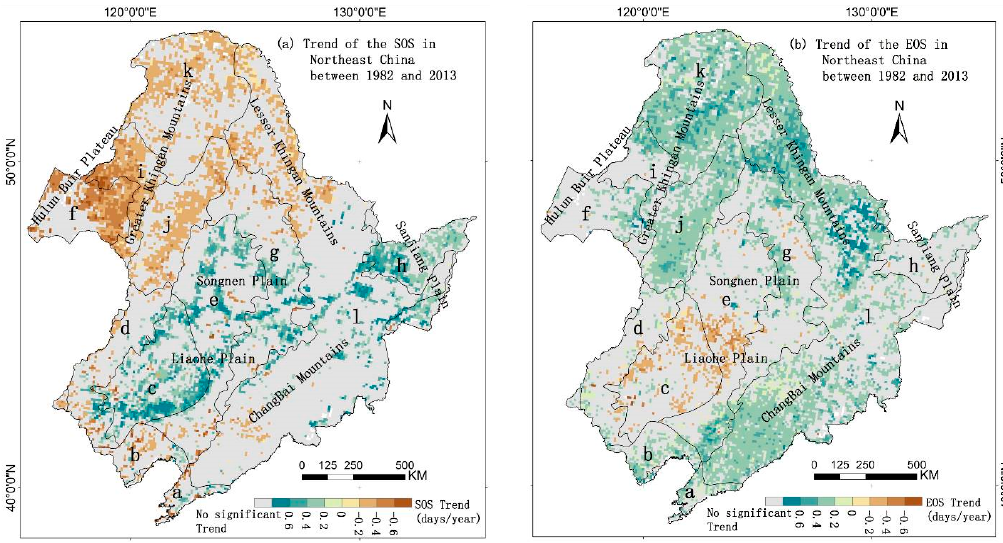
Figure 3. Trends of the SOS ( a ) and EOS ( b ) in NEC between 1982 and 2013.